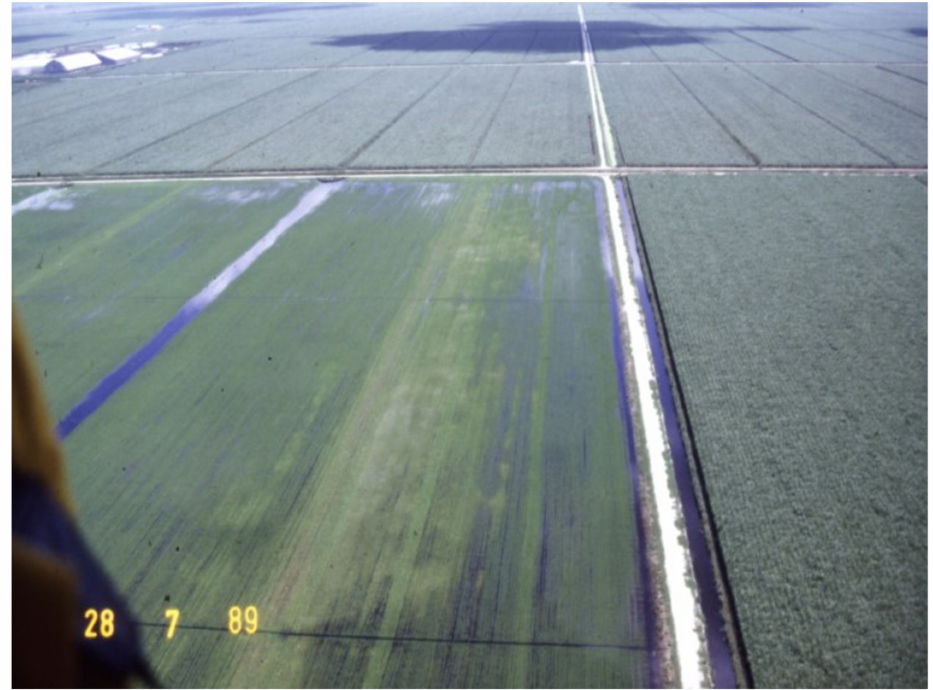
Figure 30. Wetland conversion to agriculture outside Everglades National Park—the Everglades Agricultural Area. Source: Edward